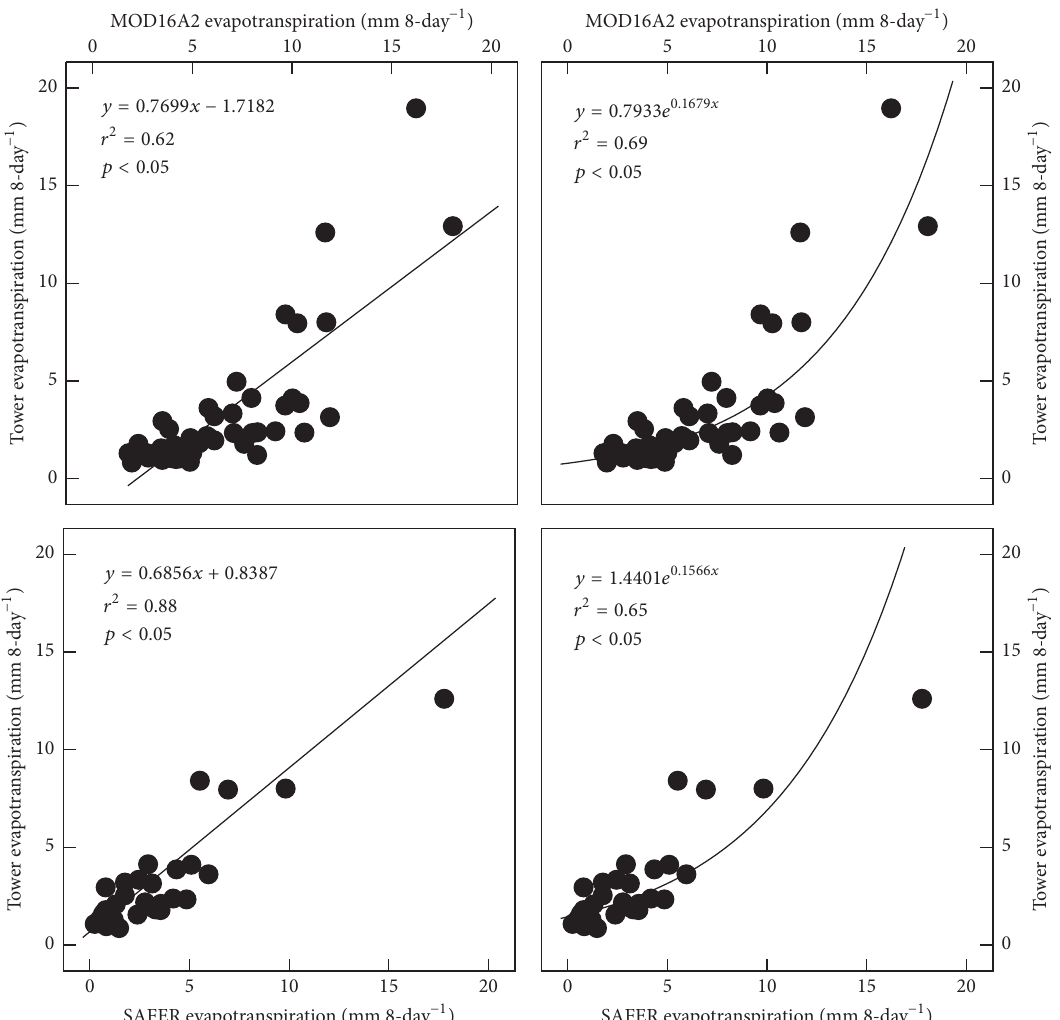
Figure 6: 8-day linear and exponential regression of MOD16A2 evapotranspiration (superior part) and SAFER evapotranspiration (inferior part) versus evapotranspiration from a Flux tower installed in an area of Caatinga at Embrapa Semi´arido, which is a research station of the state of Pernambuco, Brazil, for the year of